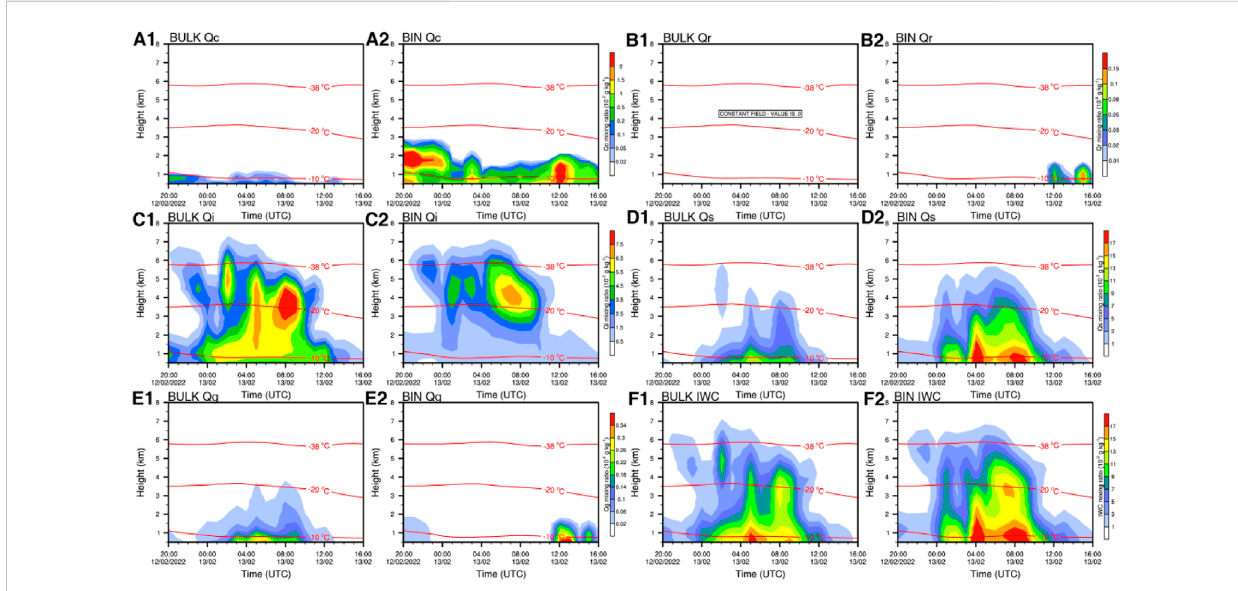
FIGURE 10 Time – height contours ofcloud hydrometeors (shading; unit: g kg − 1 )ofthe BULK and BIN simulations for 2000 UTC on February 12 to 1600 UTC on February 13, 2022: (A1,A2) cloud water (Qc), (B1,B2) rainwater (Qr), (C1,C2) cloud ice (Qi), (D1,D2) snow (Qs), (E1,E2) graupel (Qg), and (F1,F2) ice water